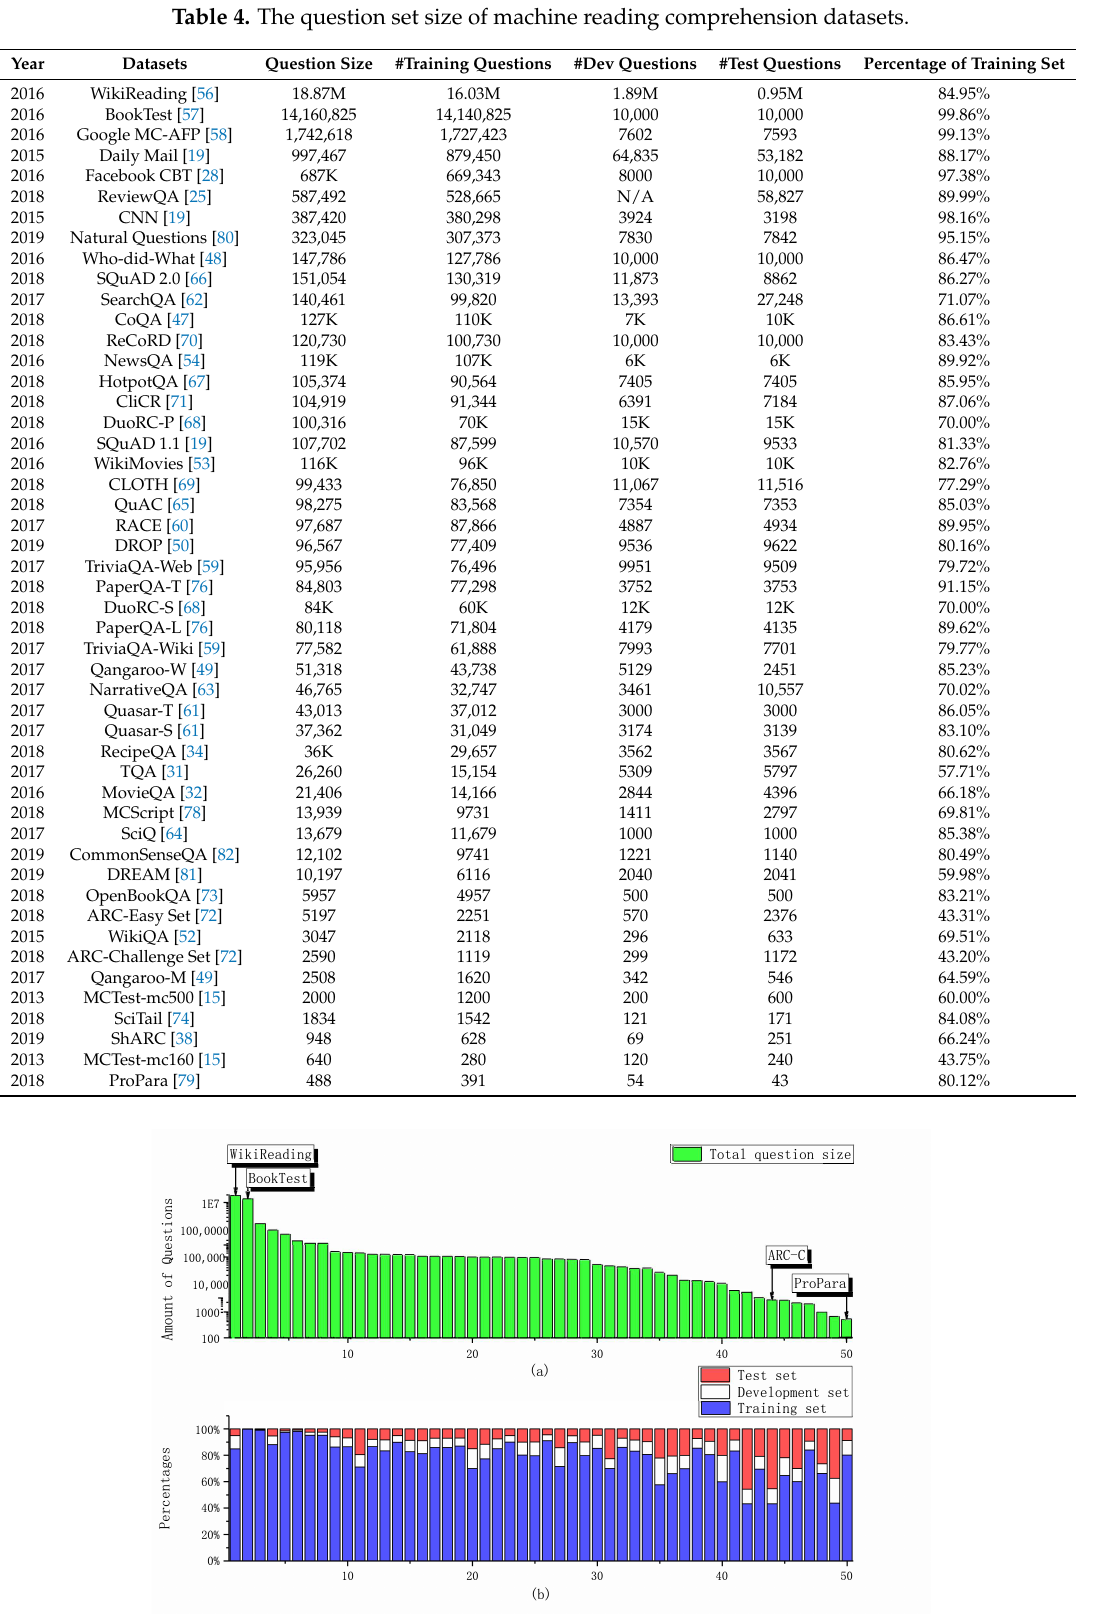
Figure 22. The size of machine Reading Comprehension datasets: ( a ) Total question size of each dataset. ( b ) Percentages of training sets, development sets and test